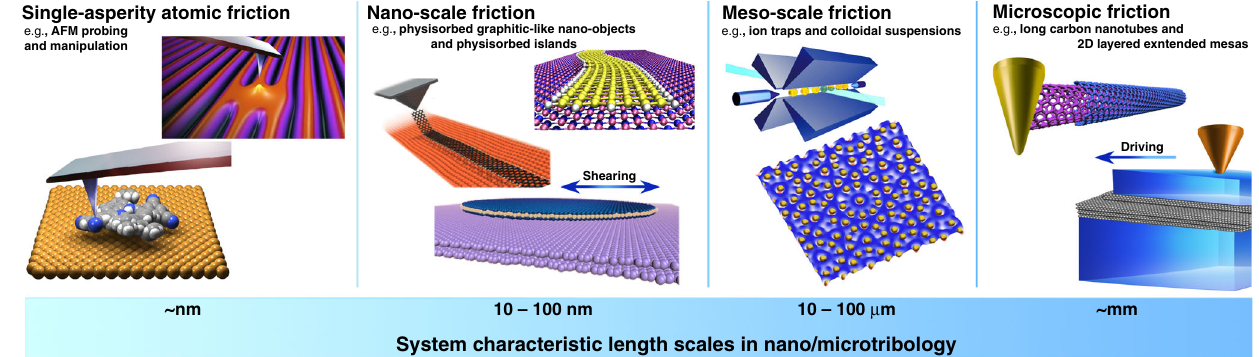
Fig. 1 Systems and length scales of nano/micro tribology: from single-asperity atomic contacts to microscopic sliding interfaces. The multifaceted discipline of tribology starts, at the shortest scale, by the investigation, via proximal-probe techniques, of a single atomistically small contact as that realized, e.g., between a sharp atomic force microscope tip, or a deposited molecule (reprinted (adapted) with permission from ref. 144 . Copyright (2016) American Chemical Society), and an underlying reference substrate. Entering into the nanoscale range of tens-of-nanometer extended adsorbates, such as AFM-manipulated graphitic ribbons (reprinted (adapted) with permission from ref. 30 . Copyright (2018) American Chemical Society) and metallic clusters, or rare-gas islands sheared by a quartz-crystal microbalance, interface geometry and incommensurability features rule the frictional response. With unprecedented real-time resolution processed at the single-particle level, the novel experimental mesoscale techniques of driven trapped cold ions and colloids have recently made crucial systematic inroads in the physics of frictional phenomena. State-of-the-art technology and fabrication procedures, especially in the realm of 2D layered materials (e.g., graphitic tubes and mesas), have nowadays offered tribology the chance to investigate atomistically well-characterized mechanical contacts up to the millimeter range and beyond. With the exponential boost of computer power in the last decades, numerical modeling and atomistic simulations are jointly advancing our theoretical understanding across all these length scales.